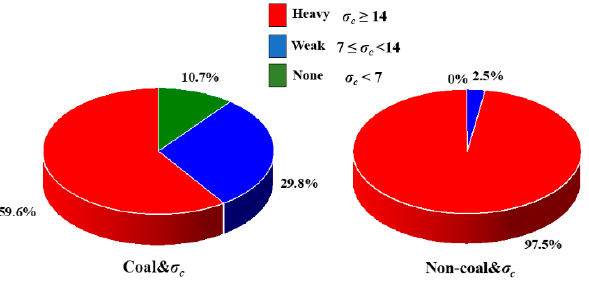
Figure 5. Proportion statistics of bursting liabilities of coal and non-coal rocks using the classification standard by uniaxial compressive strength of coal.